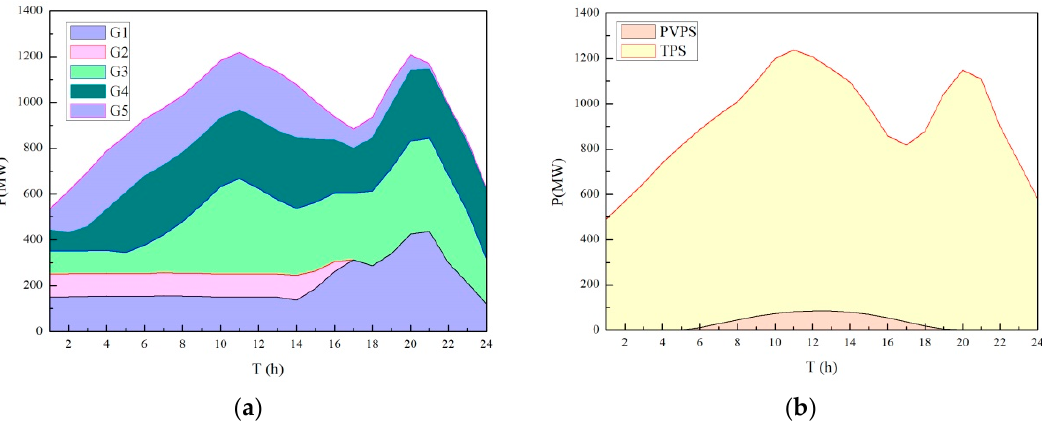
Figure 8. Output State of Each Thermoelectric Unit and Load Supply within the Park in Scenario 3. ( a ) Output State of Each Thermoelectric Unit in Scenario 3; ( b ) Load Supply Within the Park in Scenario 3.